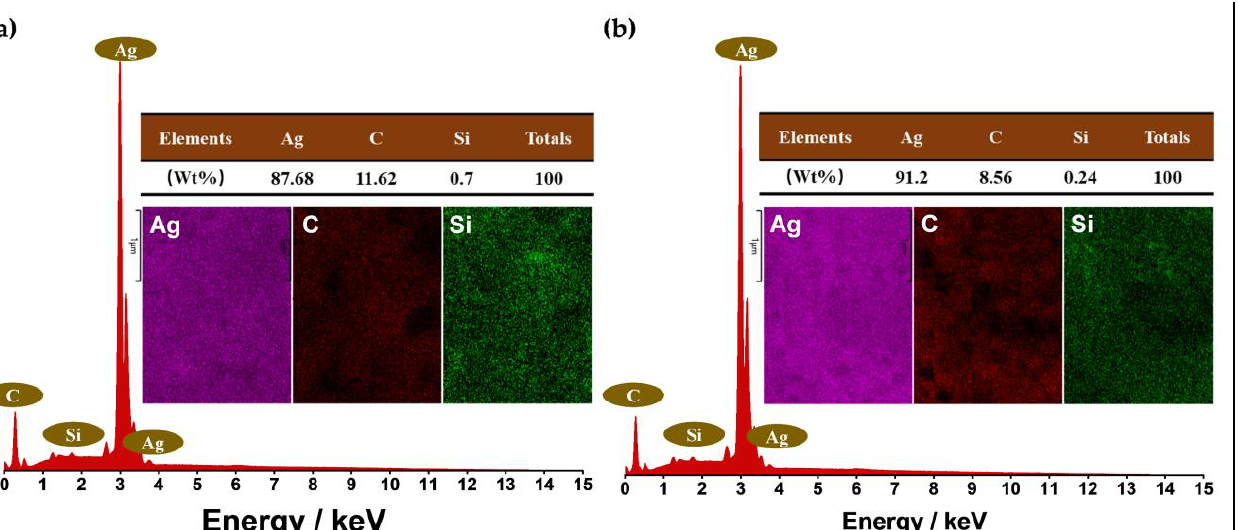
Table 2. Formulations of silver conductive inks with different solvent systems.